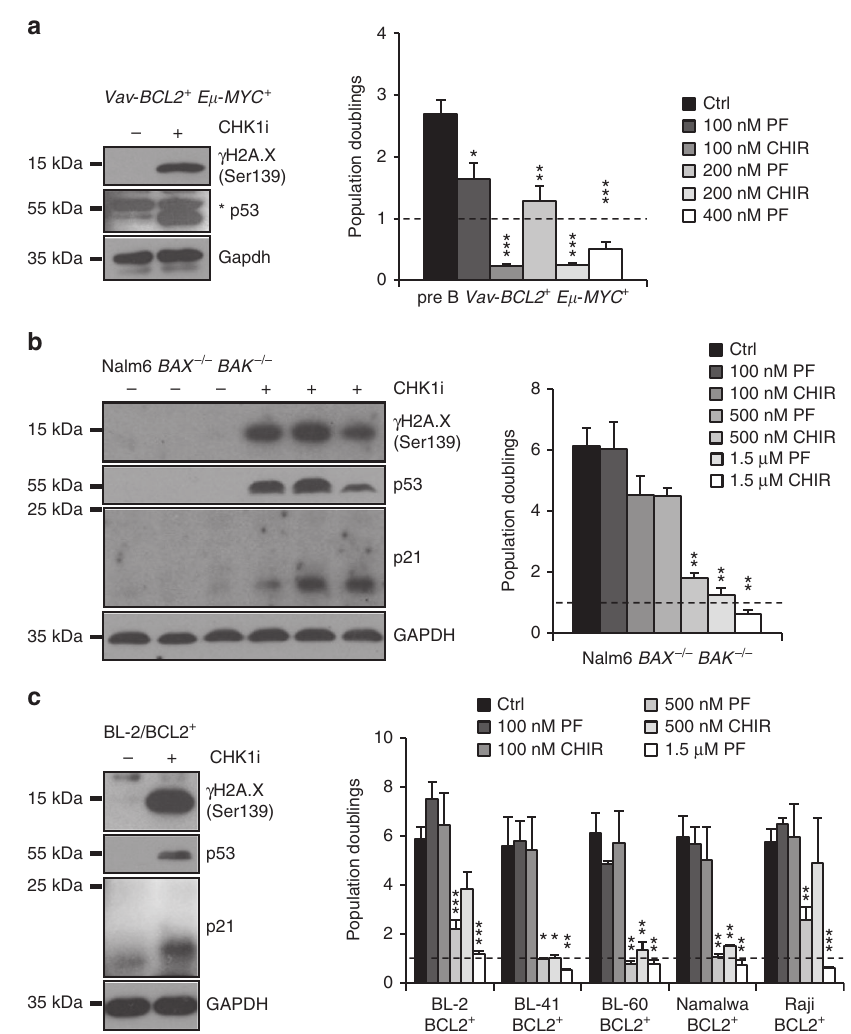
Fig. 7 CHK1 inhibition induces cell cycle arrest in apoptosis-resistant cells. a Murine primary pre B cell lines as described in Fig. 6c, d. Left: western blot analysis ± CHK1 inhibition (500 nM PF-477736). Right: population doublings 48 h after treatment with two different CHK1 inhibitors PF-477736 or CHIR- 124 or solvent control (DMSO) ( n = 3). b Nalm6 BAX − / − BAK − / − cells were treated (left) with PF-477736 (1.5 μ M) or solvent control (DMSO) and processed for western blot. Right: population doublings as described in a ( n = 4). c The BCL2 overexpressing BL-2 cell line was treated with (left) PF- 477736 (1.5 μ M) or solvent control (DMSO) and processed for western blot. Right: population doublings as described in a from indicated BCL2 overexpressing Burkitt lymphoma cell lines ( n = 3). * p53: unspeci fi c band. Bars represent means ± S.E.M., * p < 0.05, ** p < 0.01, *** p < 0.001 using unpaired Student ´ s t